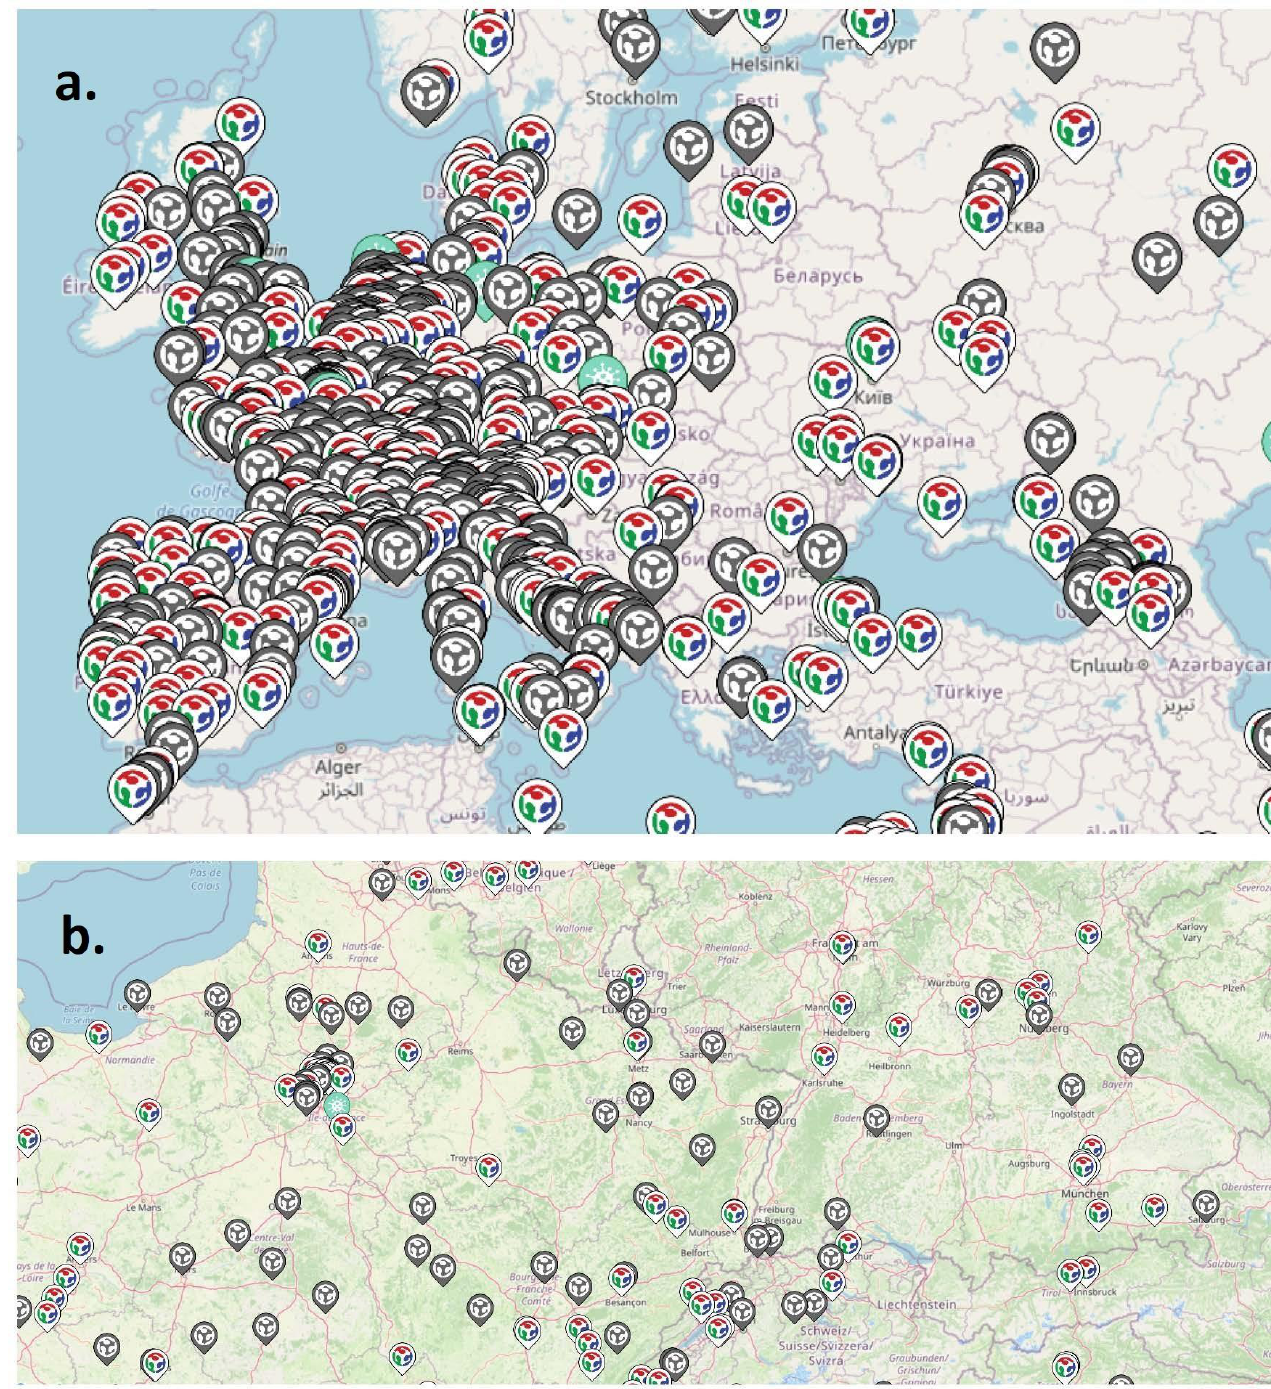
Figure 3. Fablab locations ( a ) throughout Europe and ( b ) zoomed-in view showing clustering of fablabs in population centers [205].